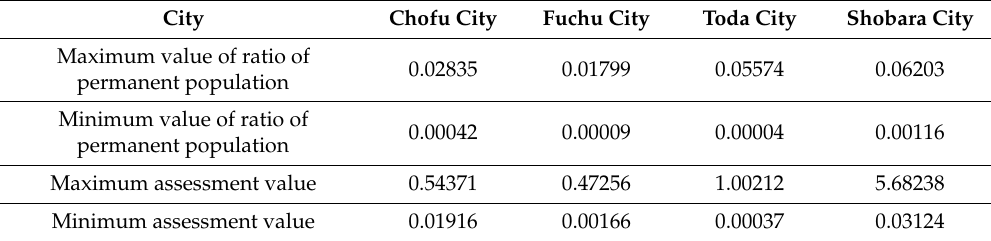
Table 6. Results with the ratio of permanent population as a weighted coe ffi cient.